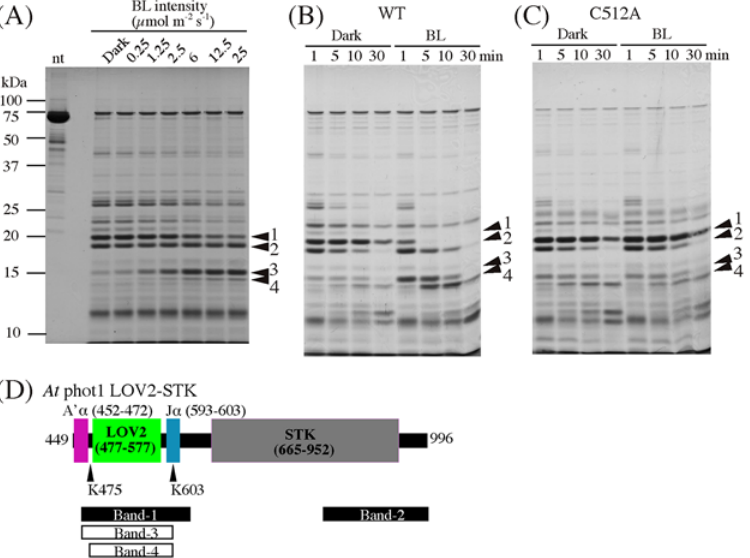
Fig 5. Peptide mapping of At phot1 LOV2-STK WT (A) and (B), and C512A (C), by SDS-PAGE after Trypsin digestion in the dark (D) or under BL irradiation (BL). nt indicates the sample without the trypsin- treatment. The gels were stained with CBB. (A) The mapping after BL irradiation with the different fluence rates for 15 min. (B) and (C) show the time courses of the digestion. The four arrowheads indicate the bands of major proteolytic products. (D) Schematic diagram for the positions of the cleavage sites for the four major bands. The black and white bars indicate the proteolytic products obtained in the dark or under BL irradiation,